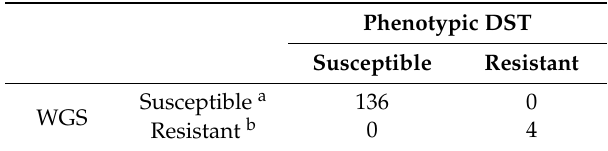
Table 6. Agreement between phenotypic DST results and identified aa exchanges in the RRDR of the rpoB gene conferring resistance to rifamycins ( N =